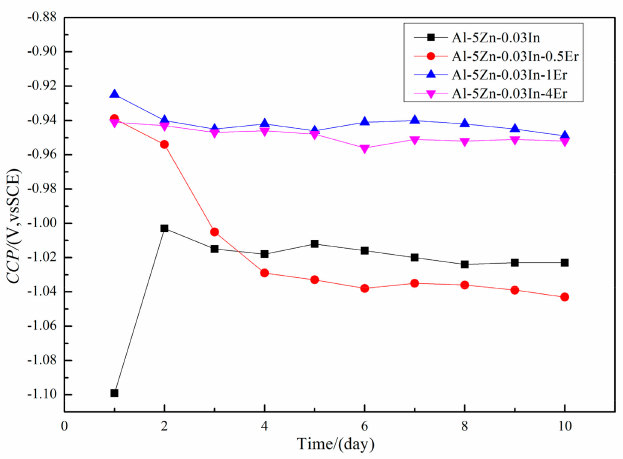
Figure 10. CCP of Al–5Zn–0.03In– x Er alloys. Calculation of current